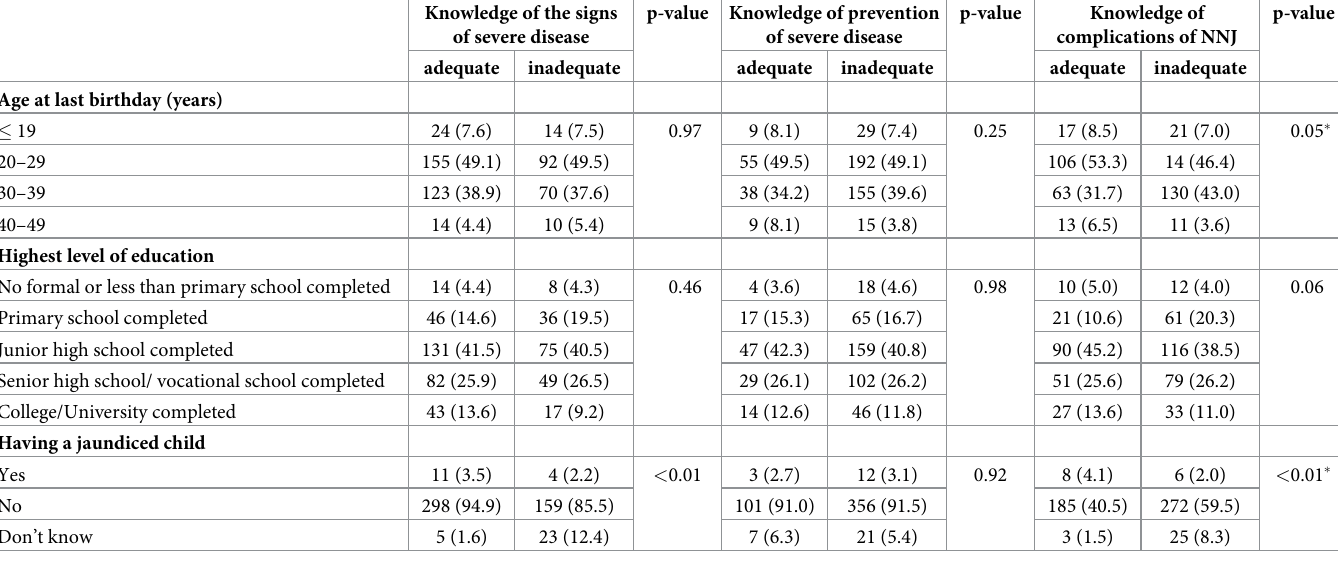
Table 5. Association between selected characteristics of mothers and knowledge of signs, prevention, and complications of severe neonatal jaundice. Knowledge of the signs of severe